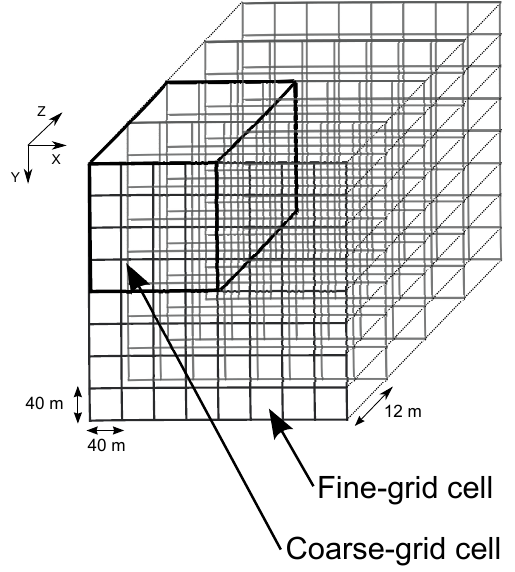
Figure 3. The domain of simulation: 8 × 8 × 4 fine cells which are grouped in 2 × 2 × 2 coarse cells.